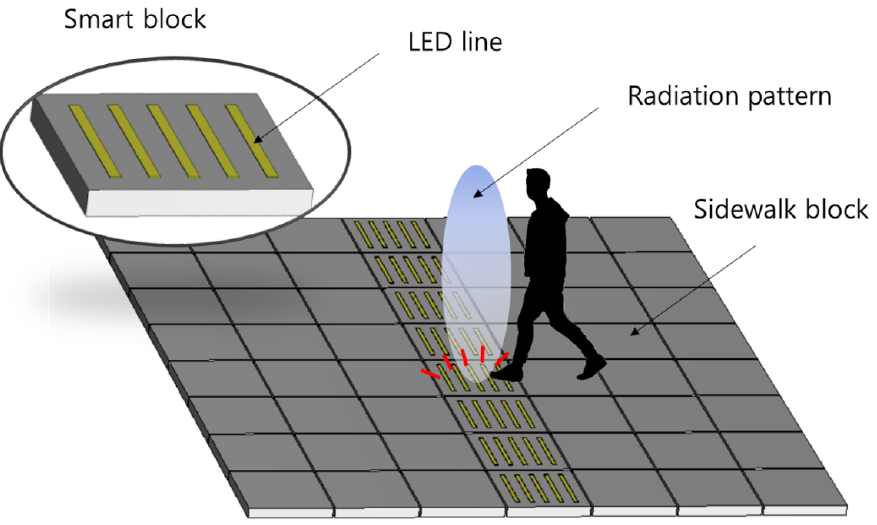
Figure 1. Schematic diagram of smart blocks for fare collection.